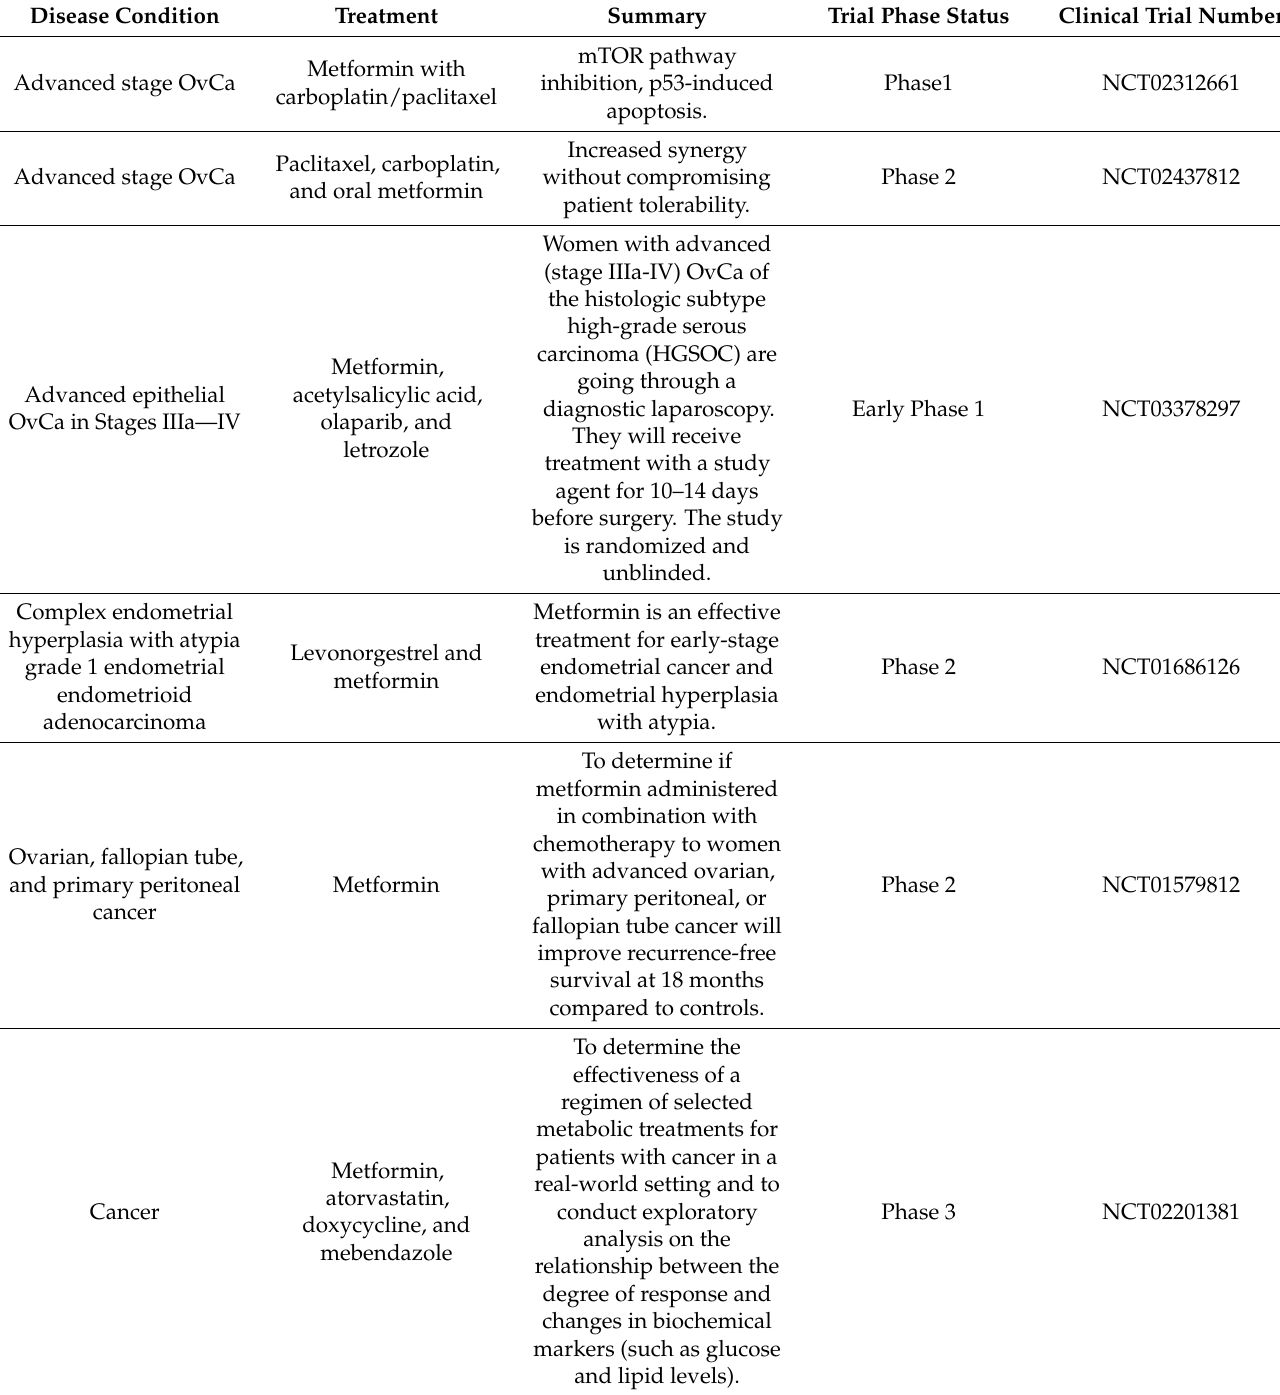
Table 1. Updates on clinical trials of metformin and